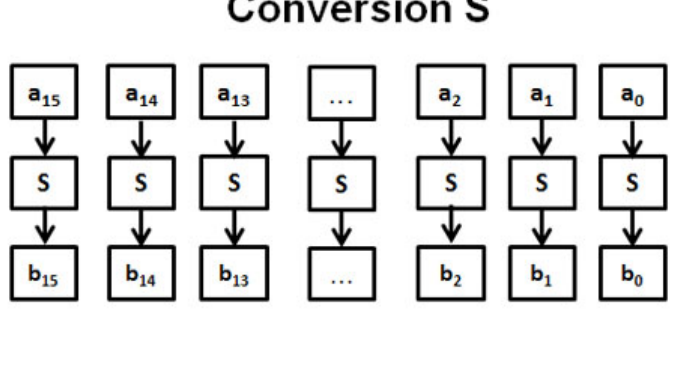
Figure 2: The scheme of conversion S